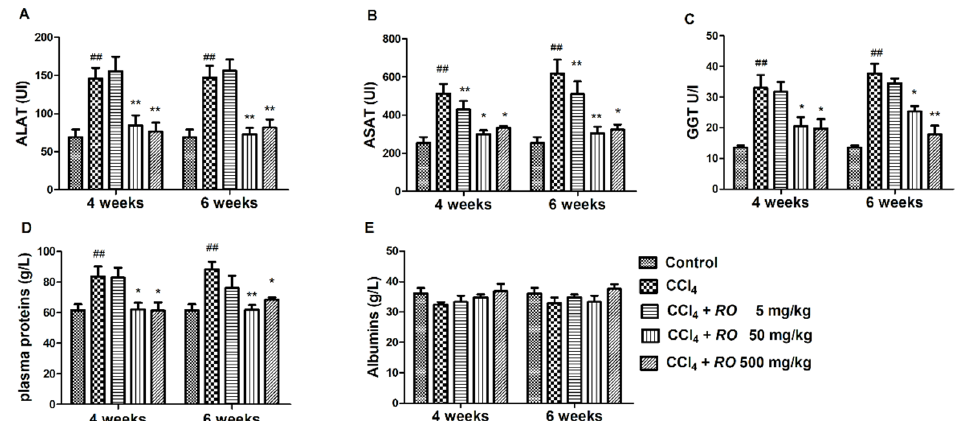
Figure 2. Effects of R. officinalis tincture on: alanine aminotransferase (ALAT) ( A ); aspartate aminotransferase (ASAT) ( B ); gamma glutamyl transferase (GGT) ( C ) activity and plasma total proteins ( D ); and albumins ( E ) concentration (mean ± SD, 5 animals/group). ## p < 0.01, compared to the Control group; * p < 0.05, ** and p < 0.01 compared to the CCl 4 alone treated group.